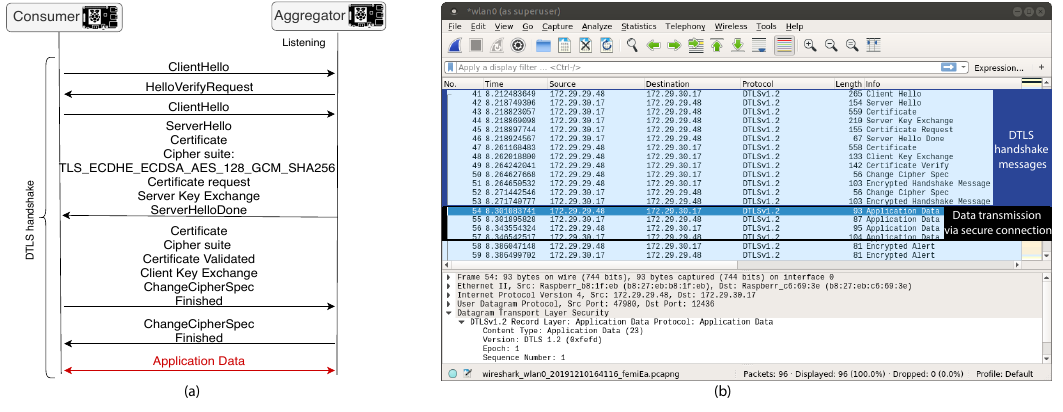
Figure 11. CoAP/DTLS handshake ( a ) and capture of the communication ( b ) between consumer- aggregator . Application data are sent authenticated and encrypted with a fresh and unique session key on a single DTLS datagram over